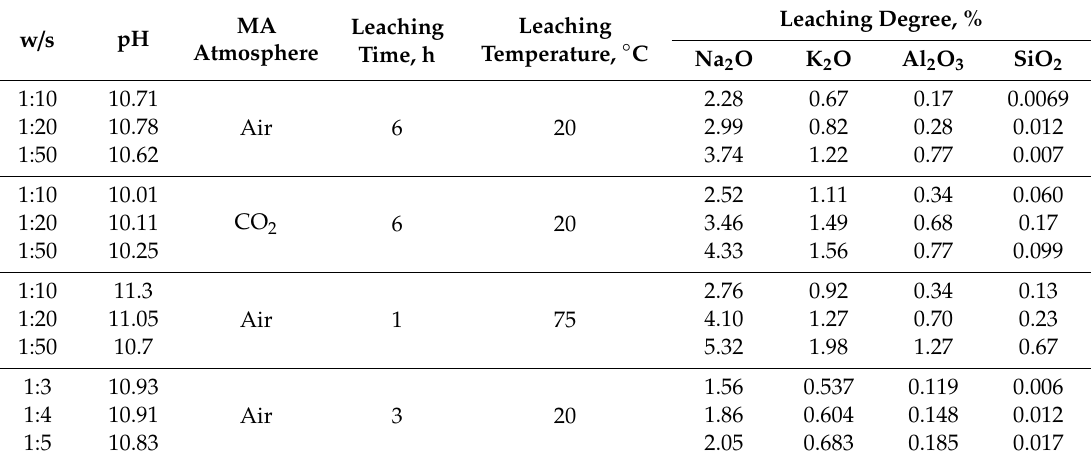
Table 4. The water leaching degree of Na 2 O, K 2 O, Al 2 O 3 , and SiO 2 from the nepheline concentrate mechanically activated for 270 s (w / s: water to solid